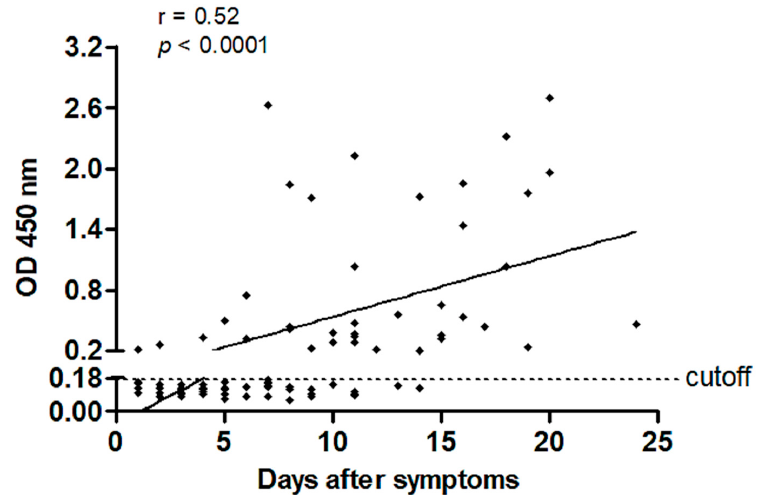
Figure 1. Association between anti-N (nucleocapsid) IgG plasma levels (optical density (OD) 450 nm) and the number of days after symptom onset in coronavirus disease 2019 (COVID-19) patients hospitalized at CHU of La R é union. A positive correlation was evidenced between these two parameters. Linear regression (solid line) is depicted in the plot. Spearman correlation coefficient (r), and p -value (one-tailed) are depicted.